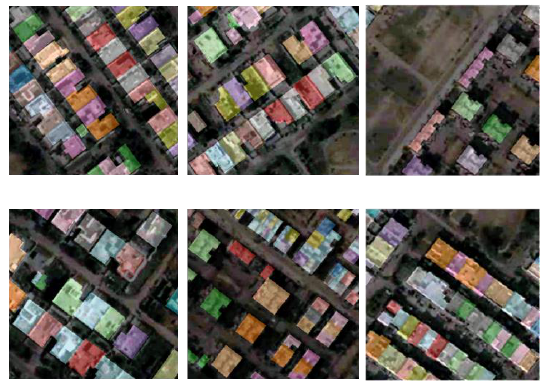
Figure 13 . Training data image tiles along with building mask 3.1.1 Trained Model Statistics: